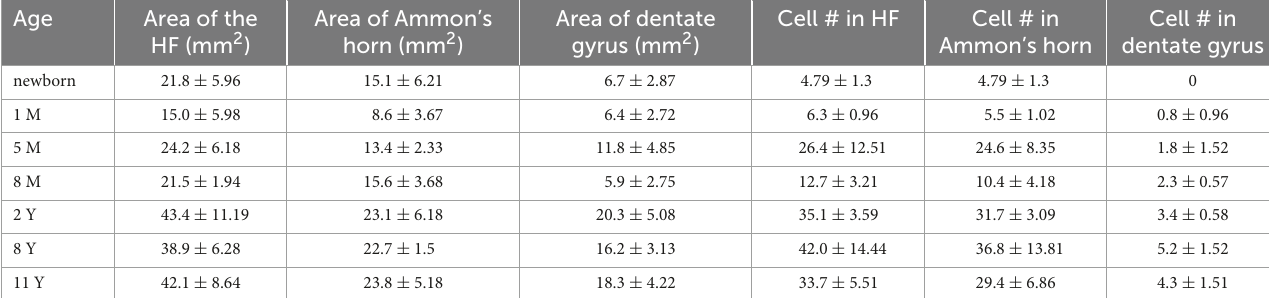
TABLE 2 Summary of the hippocampal areas and cell